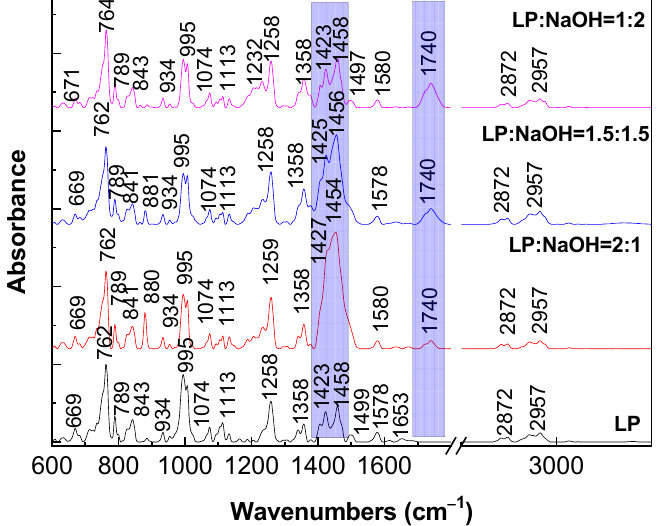
Figure 9. IR spectra of LP ( 1 ) ( black curve ) and NaOH-reacted LP ( 1 ) when the volumetric ratio LP:NaOH is 2:1 ( red curve ), 1.5:1.5 ( blue curve ) and 1:2 ( magenta curve ).